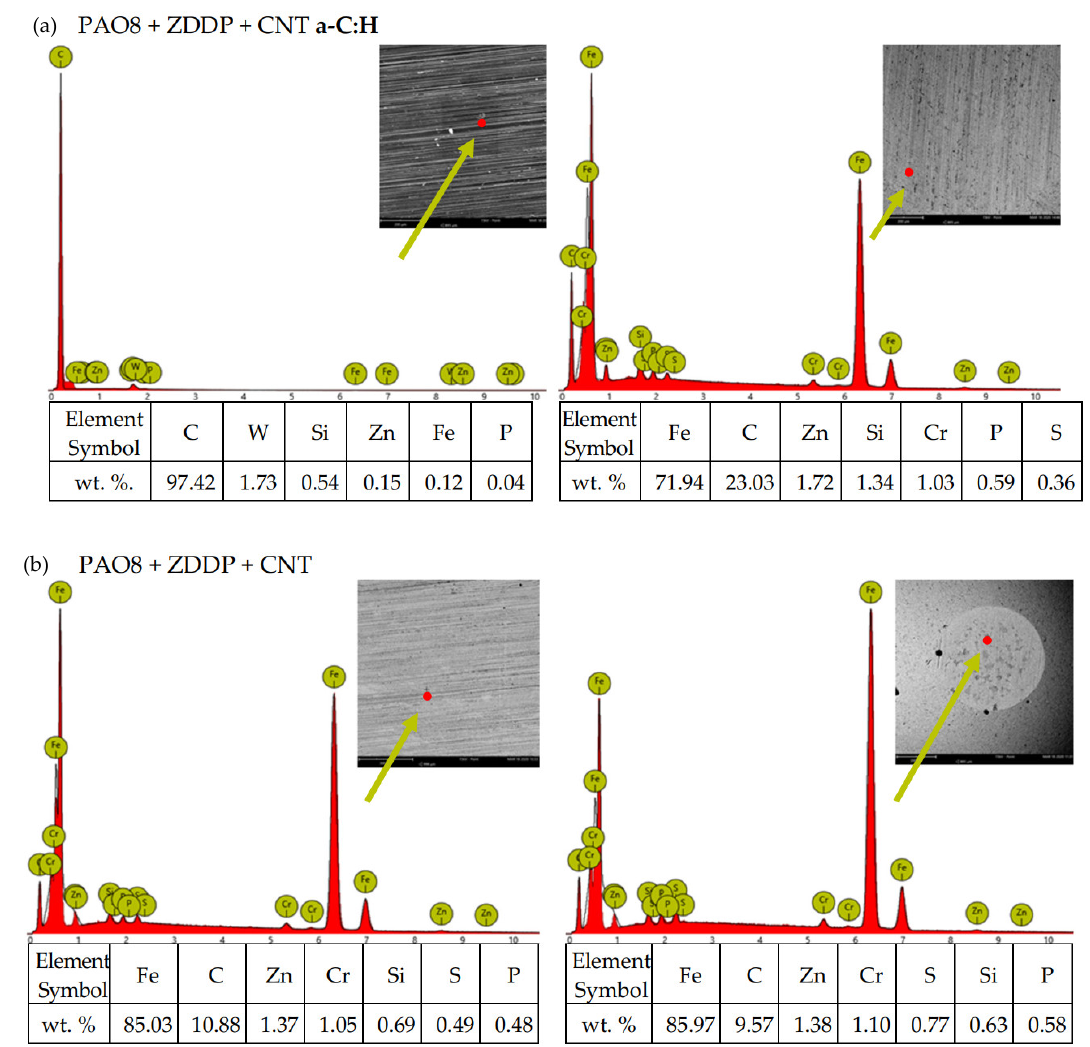
Figure 13. EDS patterns for different points of the wear track resulting from the sliding contact of the ( a ) coated and ( b ) uncoated steel discs with the steel balls—lubricant: PAO8 + ZDDP + CNT.